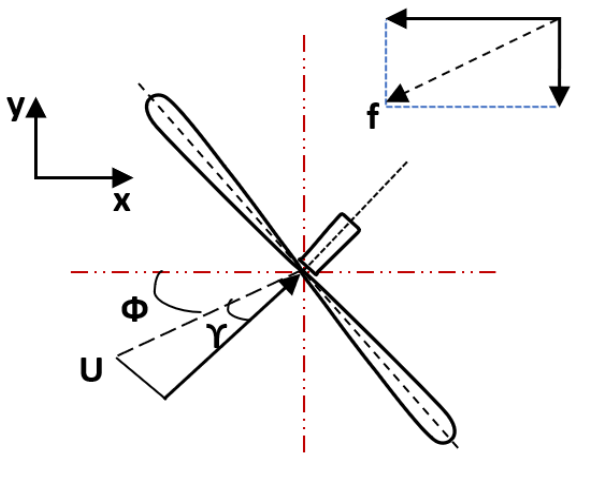
Figure 3. Top view illustration of turbine showing yaw angle γ and inflow angle φ